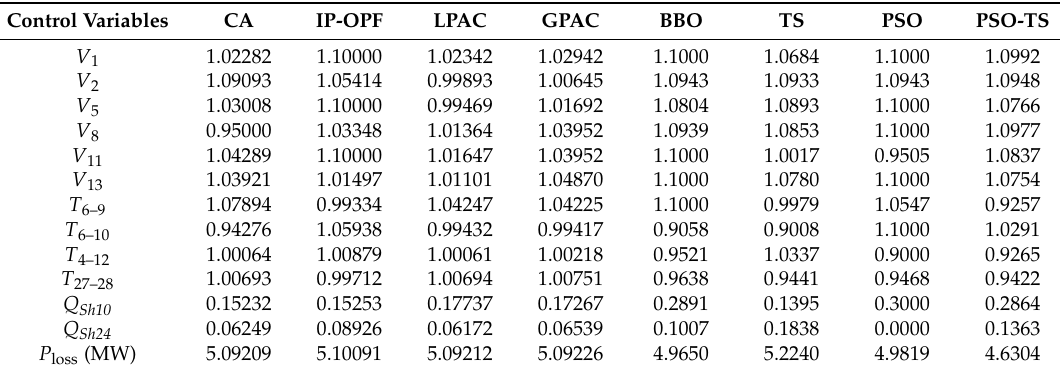
Table 2. Experimental results of TS, PSO and PSO-TS algorithms (Case 1).